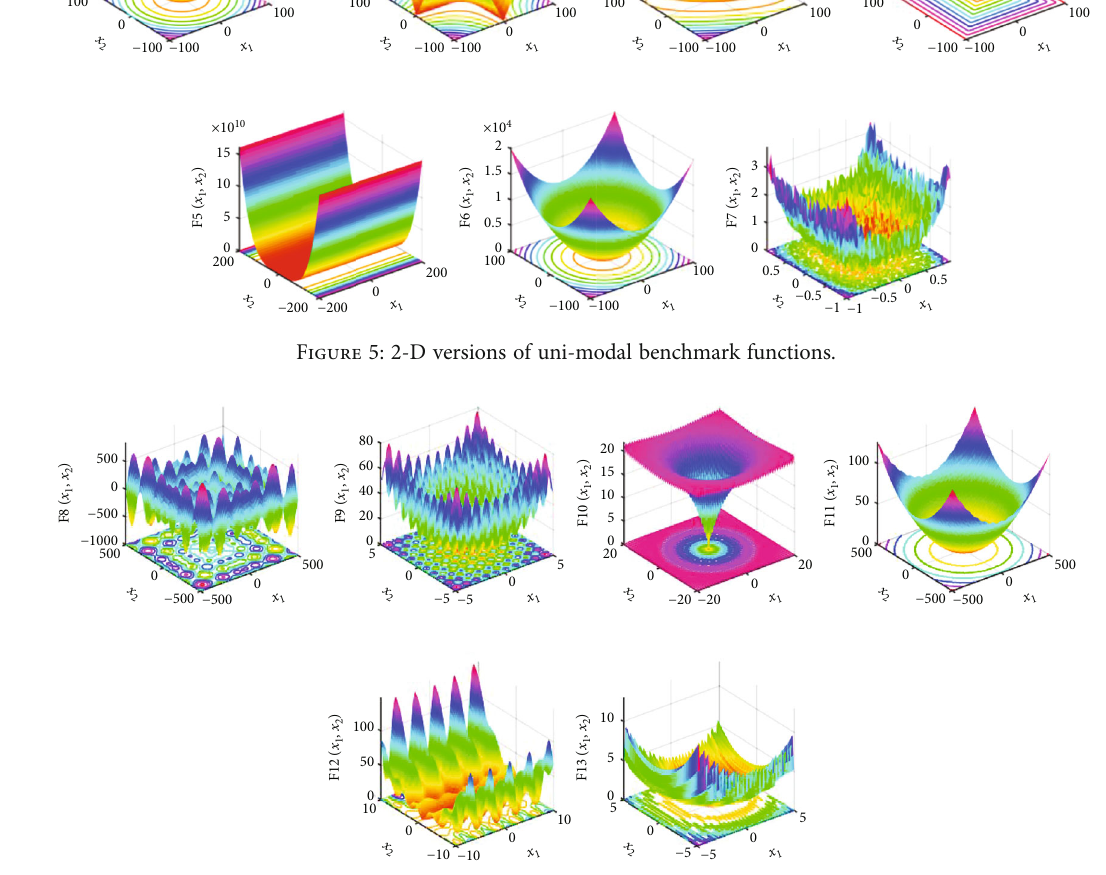
Figure 6: 2-D versions of multi-modal benchmark